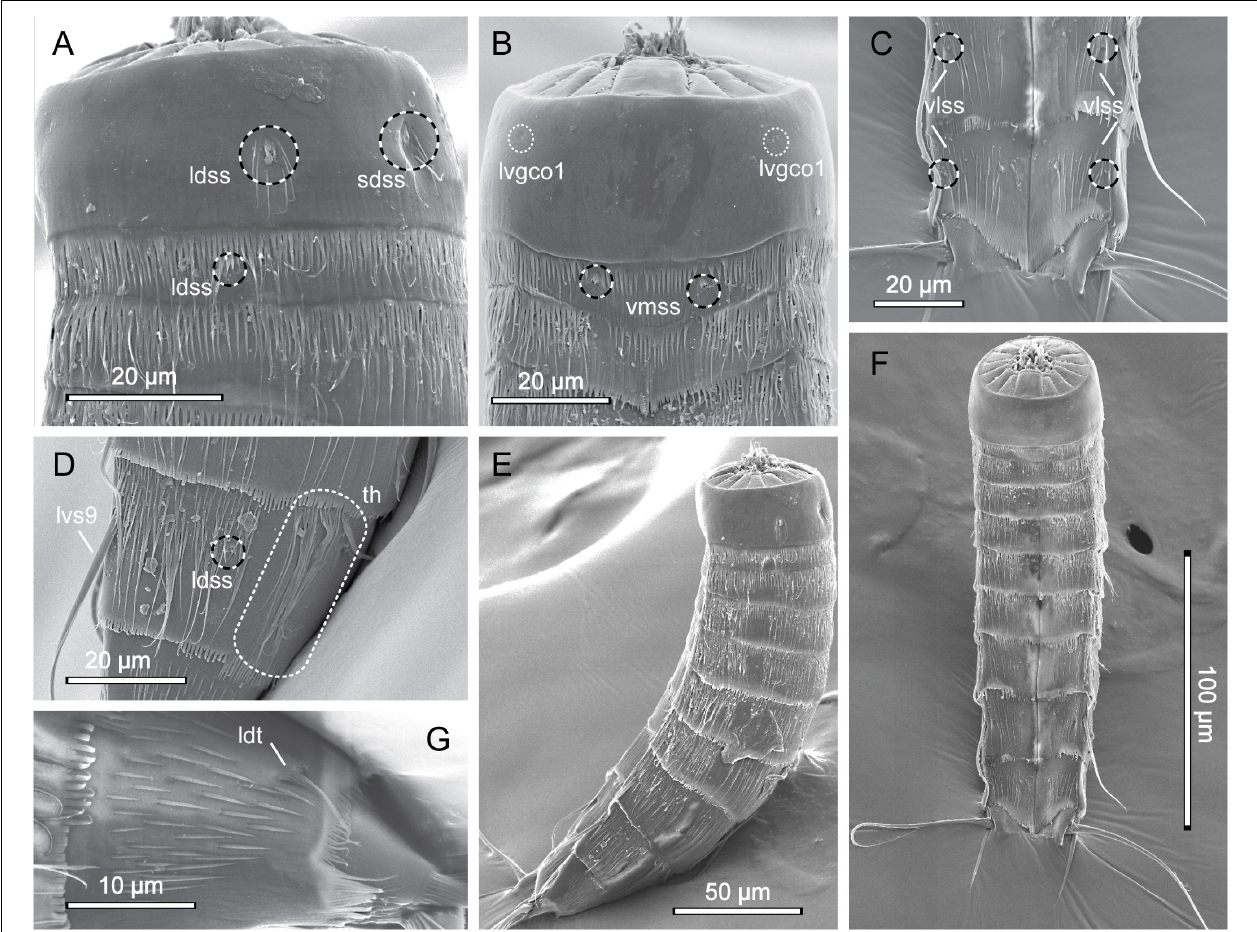
FIGURE 6 | Scanning electron micrographs showing overview and details of female Echinoderes pterus collected at station 9. (A) Segments 1 to 3, lateral view. (B) Segments 1 to 3, ventral view. (C) Segments 9 to 11, ventral view. (D) Segment 9, lateral view. (E) Lateral overview. (F) Ventral overview. (G) Segment 10, lateral view. ldss , laterodorsal sensory spot; ldt , laterodorsal tube; lvgco1 , lateroventral glandular cell outlet type 1; lvs , lateroventral spine, followed by segment number; sdss , subdorsal sensory spot; th , tuft of hairs; vlss , ventrolateral sensory spot; vmss , ventromedial sensory